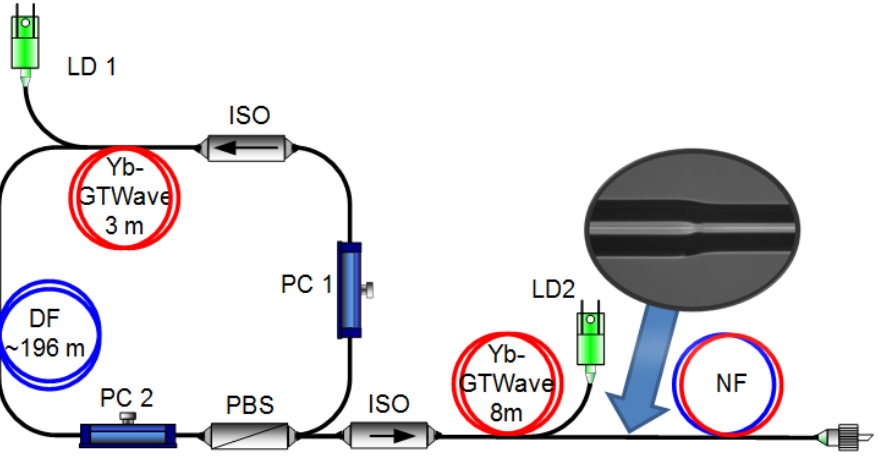
Figure 1. Experimental setup: ISO—optical isolator, LD1,2—pump laser diodes, PC1,2—polarization controllers, DF—delay fiber, PBS—polarization beam splitter, NF—nonlinear fiber.